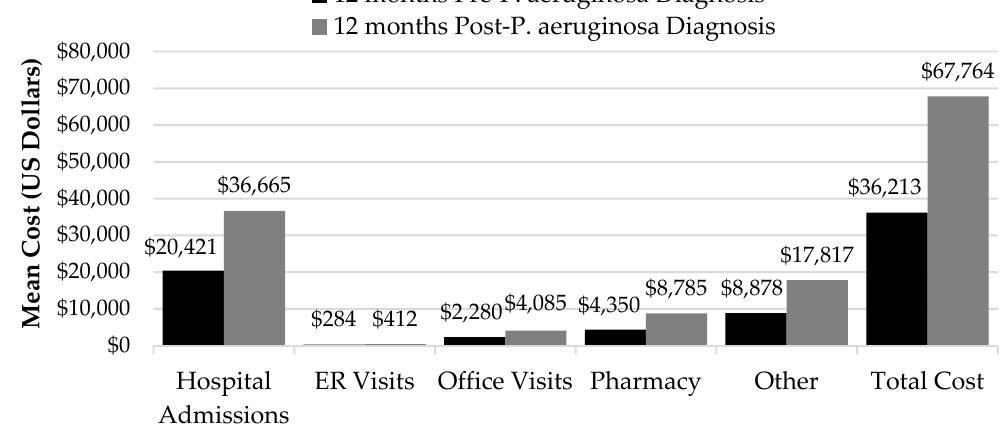
Figure 1. All-cause healthcare costs (pre- vs. post- P. aeruginosa Figure 1. All ‐ cause healthcare costs (pre ‐ vs. post ‐ P. aeruginosa ).